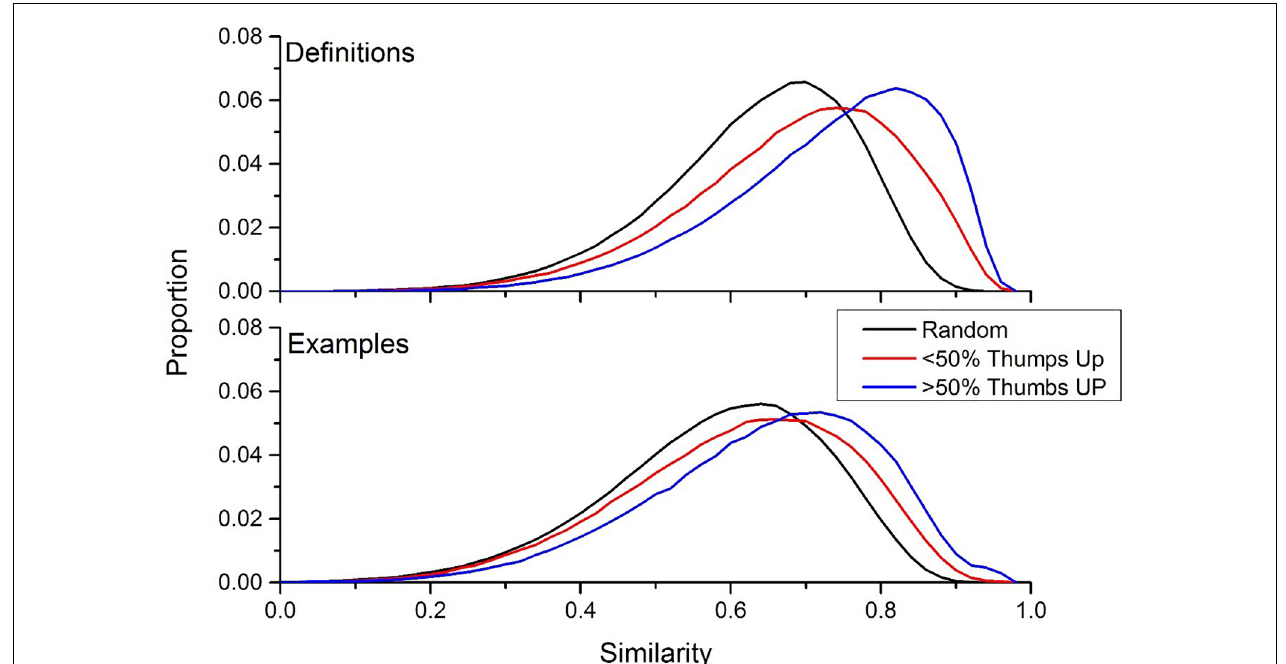
FIGURE 5 | The intra-similarity distributions for definitions that have a percent thumbs up less than 50% (red line) and percent thumbs up greater than 50% (blue line). This result indicates that definitions that receive positive reception by the UD community have more internal consistency than definitions that are